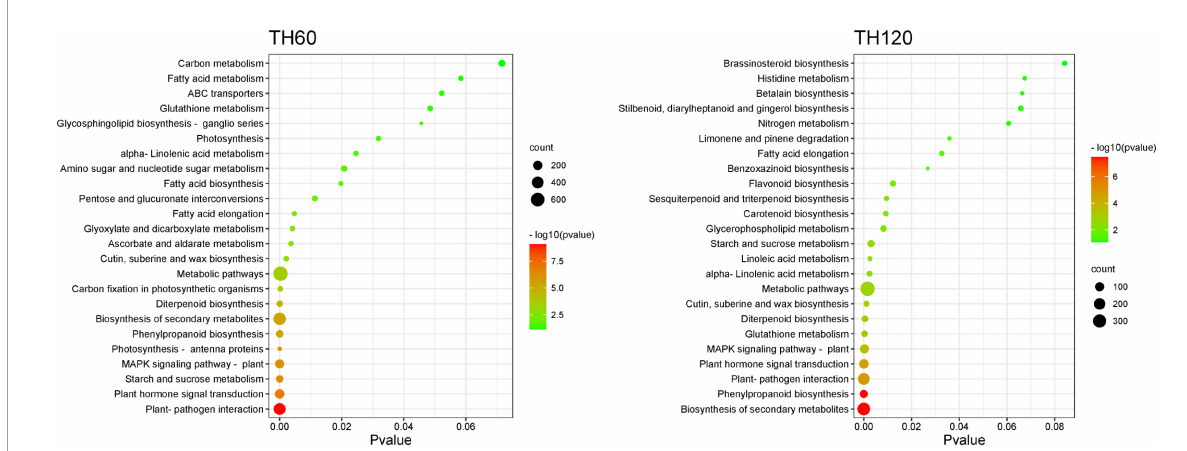
FIGURE3 Top 24 pathways of KEGG enrichment of DEGs in HD961.